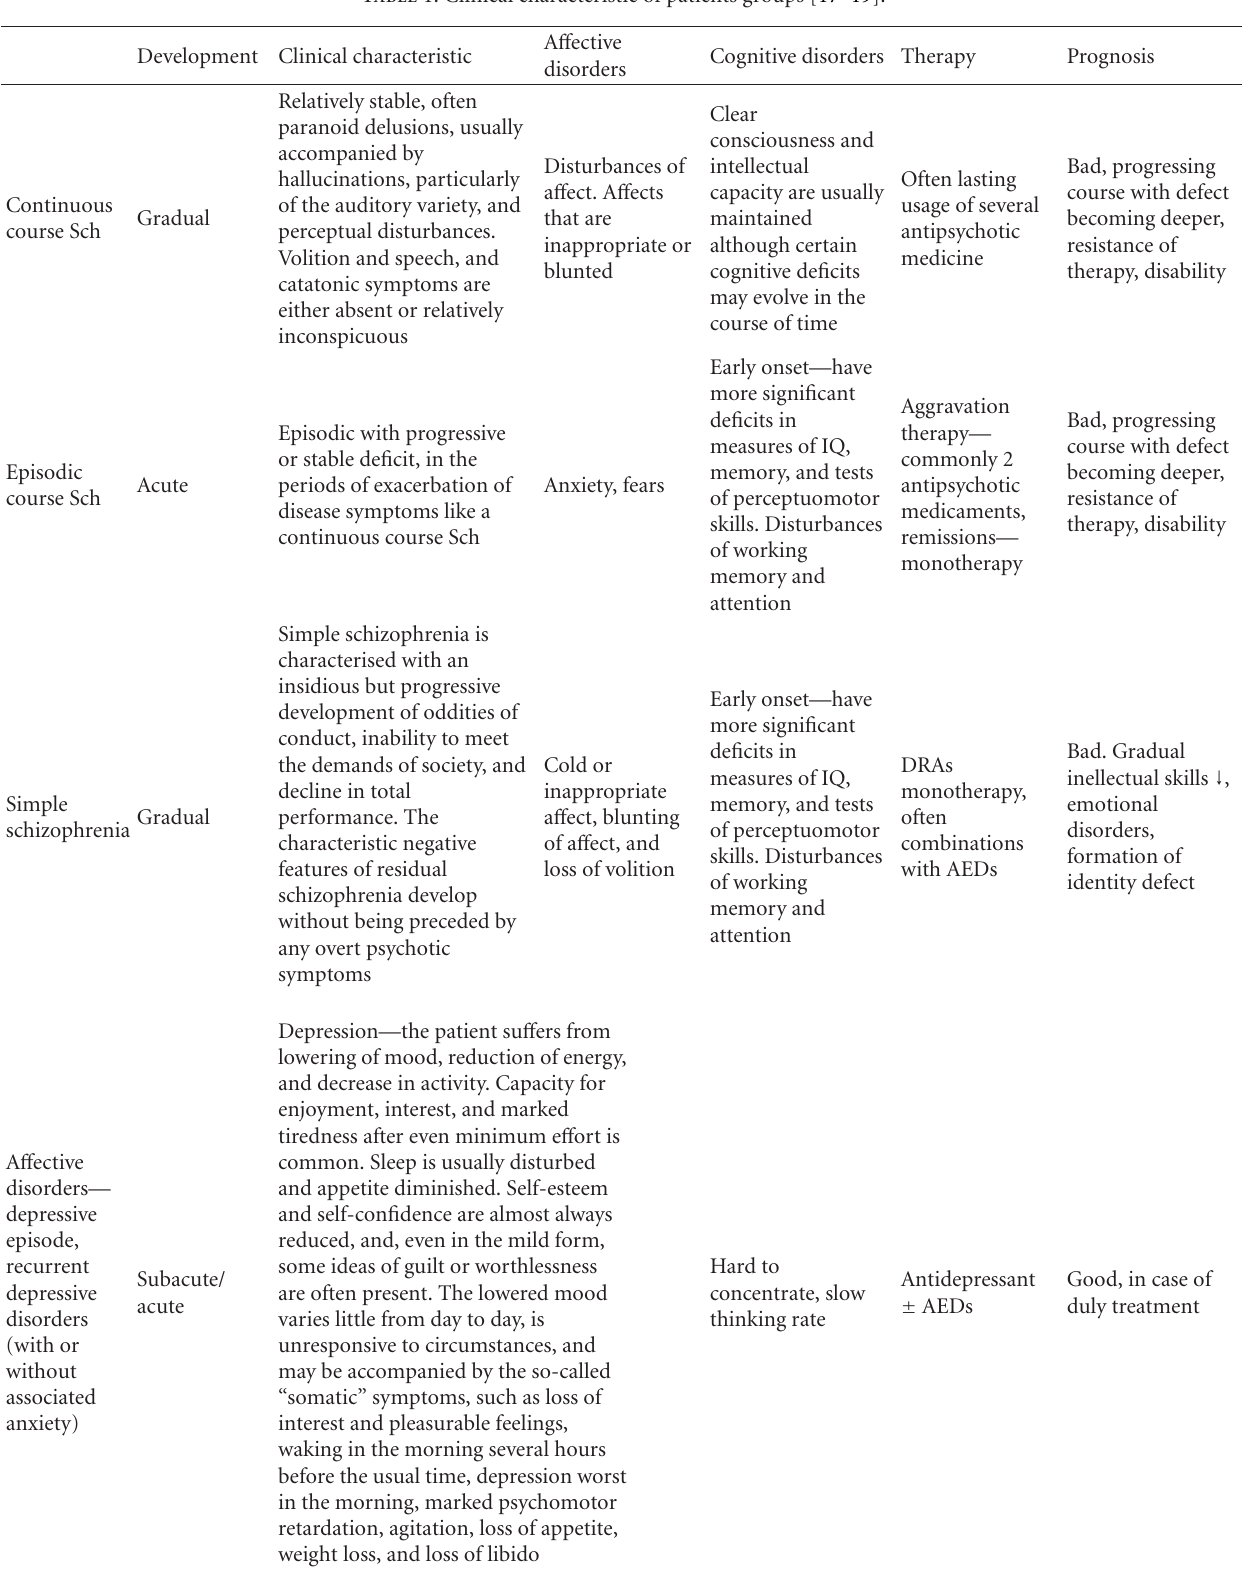
Table 1: Clinical characteristic of patients groups